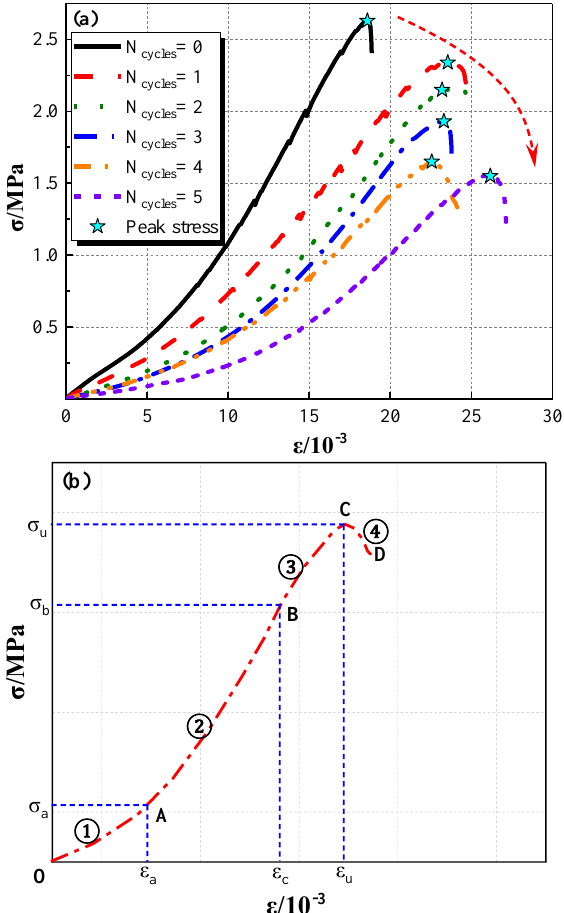
Figure 3. Results of uniaxial compression test: ( a ) stress–strain curve; and ( b ) simplified illus- tration.